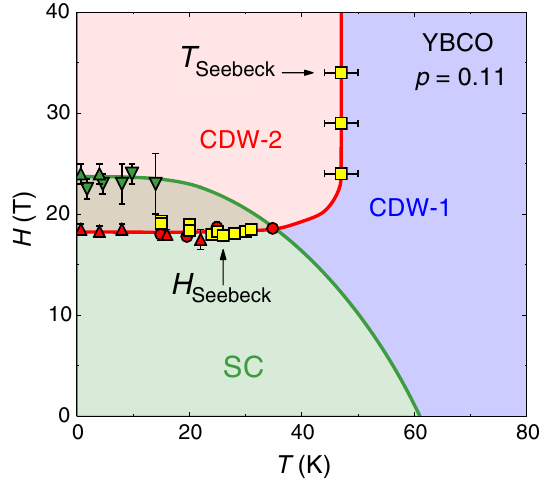
FIG. 4. Magnetic field-temperature phase diagram of YBCO at p ¼ 0 . 11 , showing the field H (Fig. 3) above which, Seebeck and the temperature T (Fig. 5) below which, the strong Seebeck anomalous anisotropy in the Seebeck coefficient appears (yellow squares). H is seen to coincide with the threshold field Seebeck detected in the sound velocity (red circles; Ref. [29]) and in the thermal Hall conductivity κ xy (red triangles; Ref. [36]) of YBCO at p ¼ 0 . 11 . The upper critical field H c 2 (green down triangles from Ref. [32], green up triangles from Ref. [36]) is also shown, delineating the superconducting (SC) phase. The green line is a guide to the eye ending at the zero-field T c . Short-range 2D bidirectional CDW modulations (CDW-1) are detected by XRD throughout this phase diagram, both in the blue region above the red and green lines, as well as below (to the left of) those lines. In addition, long-range 3D unidirectional modulations (CDW-2) are FIG. 5. (a) Seebeck coefficient of YBCO at p ¼ 0 . 11 along the a detected in YBCO in a region very similar to the red region axis (blue points) and b axis (red points), at H ¼ 34 T, plotted as defined here, namely, with an onset temperature T ≃ 47 K and S=T versus T . The blue line is a smooth fit to the S a data; the red field H ≃ 18 T at p ¼ 0 . 11 [28], and T ≃ 47 K and H ≃ 15 T at line is the same line shifted down by 0 . 1 μ V = K 2 . The anomalous p ¼ 0 . 12 [27]. The red line is a guide to the eye. feature seen in the field dependence of S b (Fig. 2) shows up in the temperature dependence of S b =T initially as a plateau. Inset: Difference between the b -axis data points and the red line (fit) in the top panel (red dots). The green dots are obtained using the S b data of Fig. 1(b). The onset temperature for the extra anisotropy ¼ 47 (cid:2) 5 K (arrow). (b) S =T versus T , in YBCO at is T a Seebeck p ¼ 0 . 12 , for three field values as indicated. At all fields, 2D bidirectional CDW modulations (CDW-1) are observed in the blue and red regions [37], while 3D unidirectional CDWorder (CDW-2) is observed only in the red region and only when H > 15 T [27,28]. The dashed line is a smooth extension of the high- T data below its inflection point at T ¼ 130 K. The red line is a smooth guide through the red data